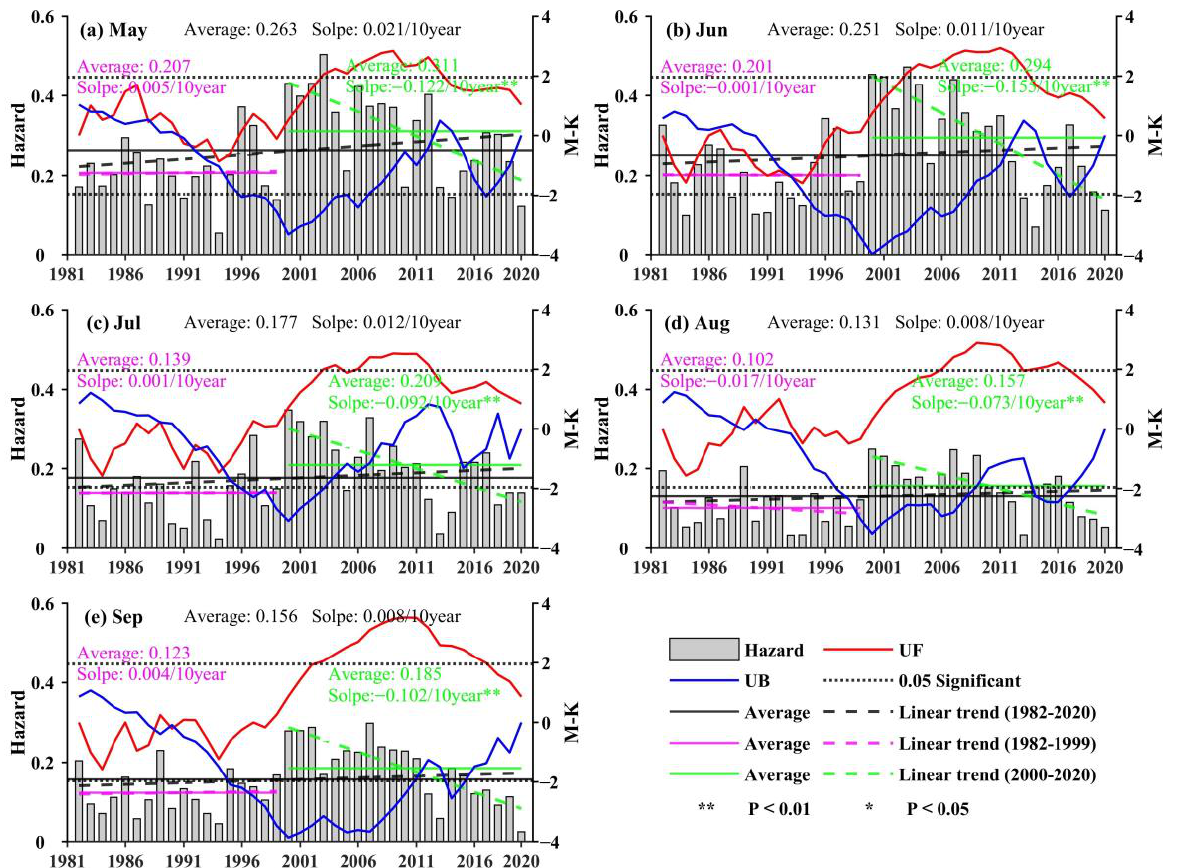
Figure 11. Temporal variation of drought hazard during the growing season in NEC, 1982 – 2020 ( a – e ).